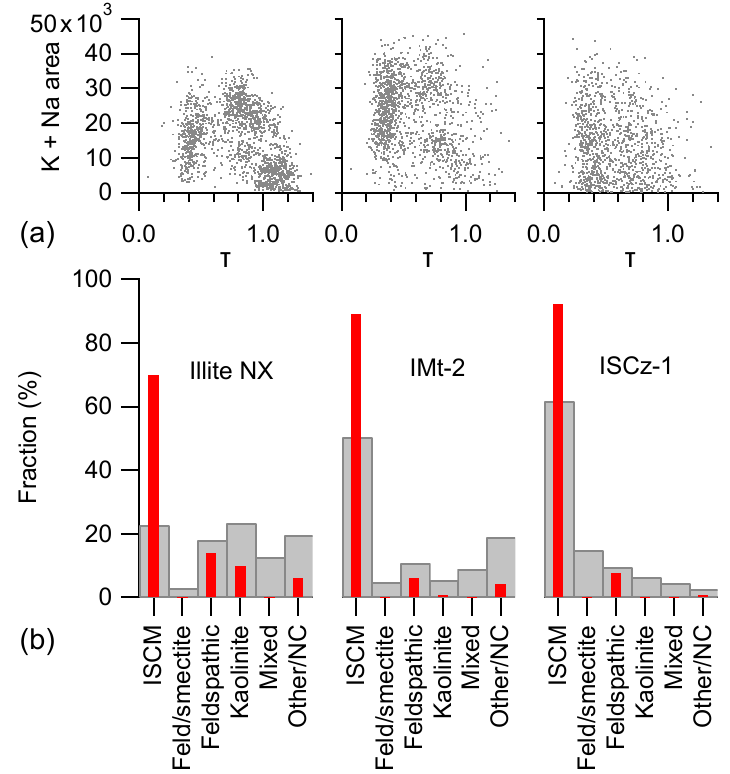
Figure 11. Mineral-phase classification of illite NX, IMt-2 and ISCz-1 clay reference samples using a combined peak position shift and traditional peak area classification scheme. Single-particle measurements of (cid:49)T O /(cid:49)T SiO content are shown in the top panel (a) . Panel (b) reports the particle number fractions determined by the peak analysis classification method (grey bars), and bulk mass fractions of minerals reported by XRD analysis of illite NX from Hiranuma et al. (2015), and IMt-2 and ISCz-1 from Vogt (2002) (red